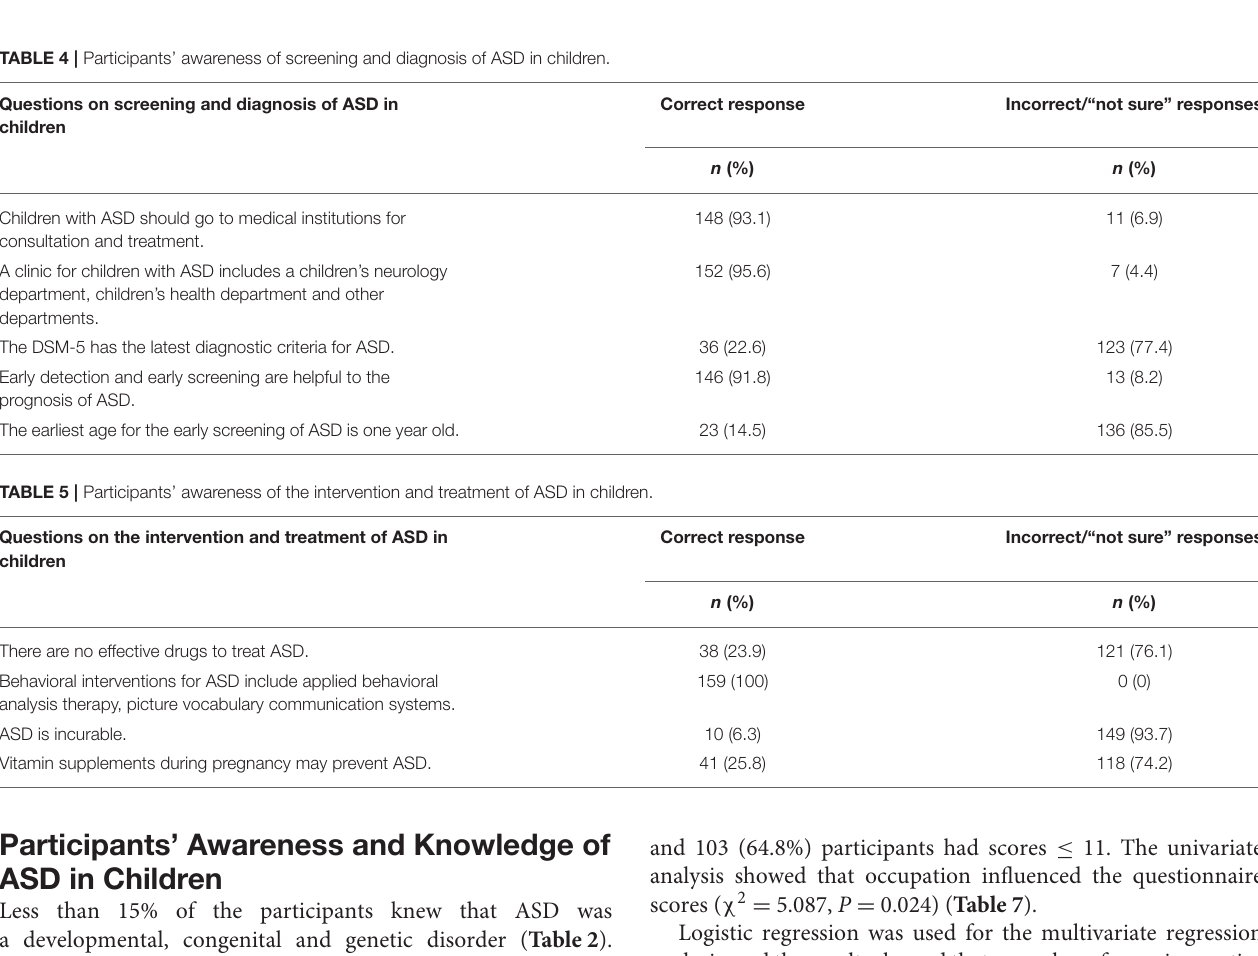
TABLE 4 | Participants’ awareness of screening and diagnosis of ASD in children. Questions on screening and diagnosis of ASD in children